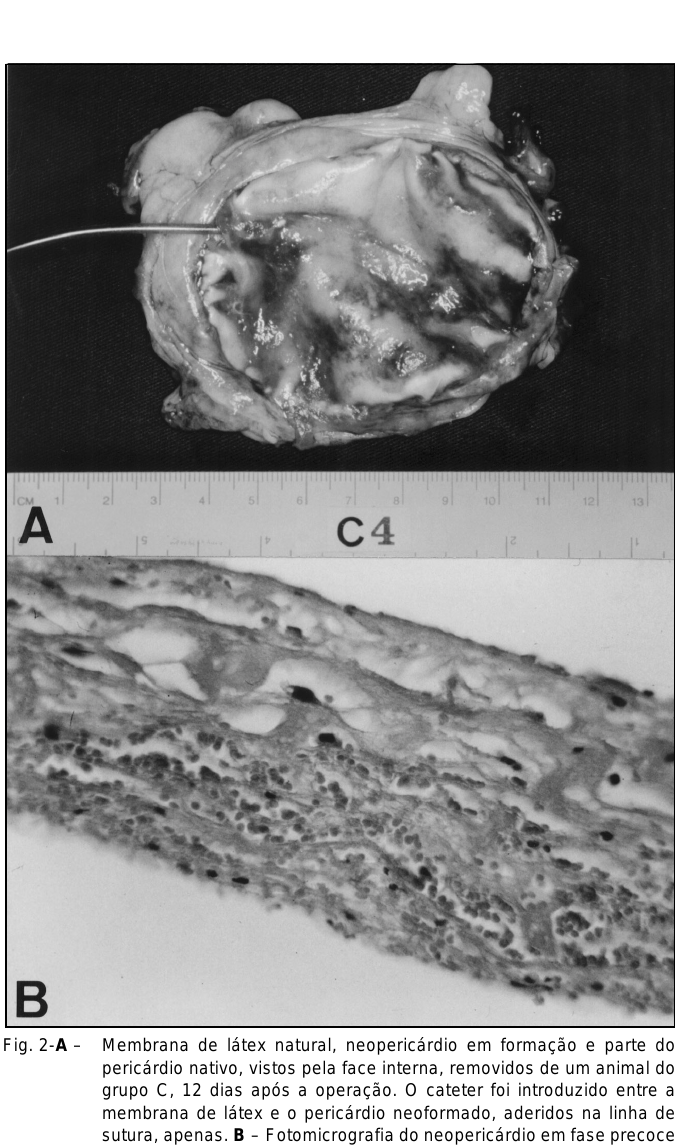
faces (Figura 2-B). Nos demais cães dos grupos B e C, o epicárdio subjacente à membrana de látex apresentava-se ligeiramente espessado, permitindo, contudo, visibilizar facilmente os vasos coronários (Figura 3-A). Microscopicamente, identificaram-se algumas áreas com denso infiltrado linfo-plasmocitário e proliferação fibroblática e vascular revestida por fibrina. Em outros locais, os fibroblastos circunscre- viam fendas e recessos revestidos por células mesoteliais bem definidas (Figura 3-B). Não se observou nem infecção local, nem alte- ração do leucograma em qualquer animal e, no eletrocardiograma constatou-se, apenas, inversão da onda T em todos os grupos.